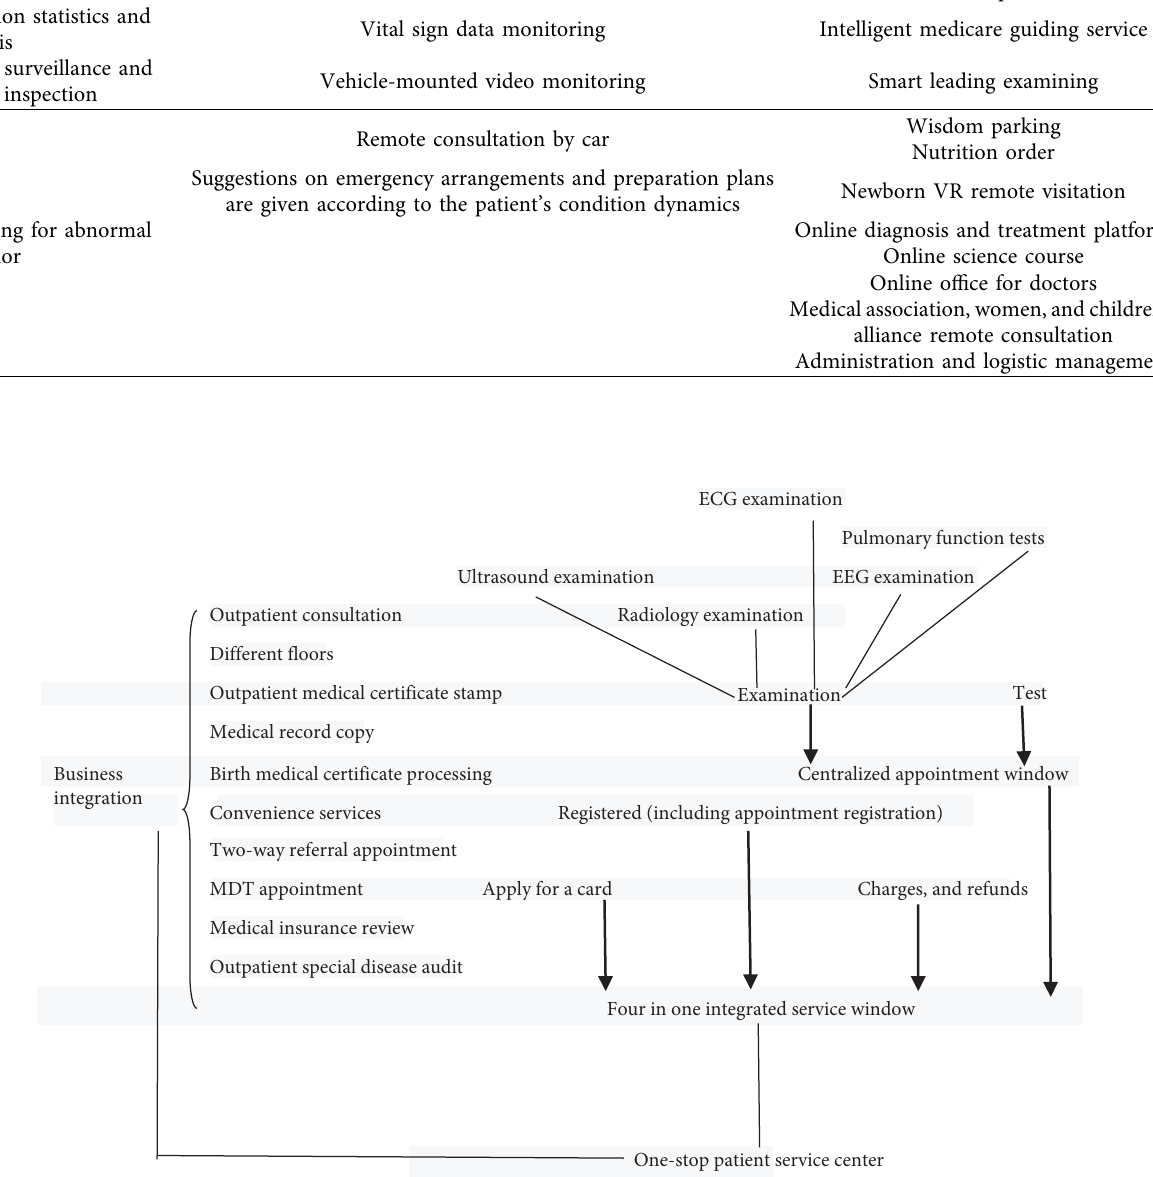
Figure 4: One-stop service integration structure frame diagram.